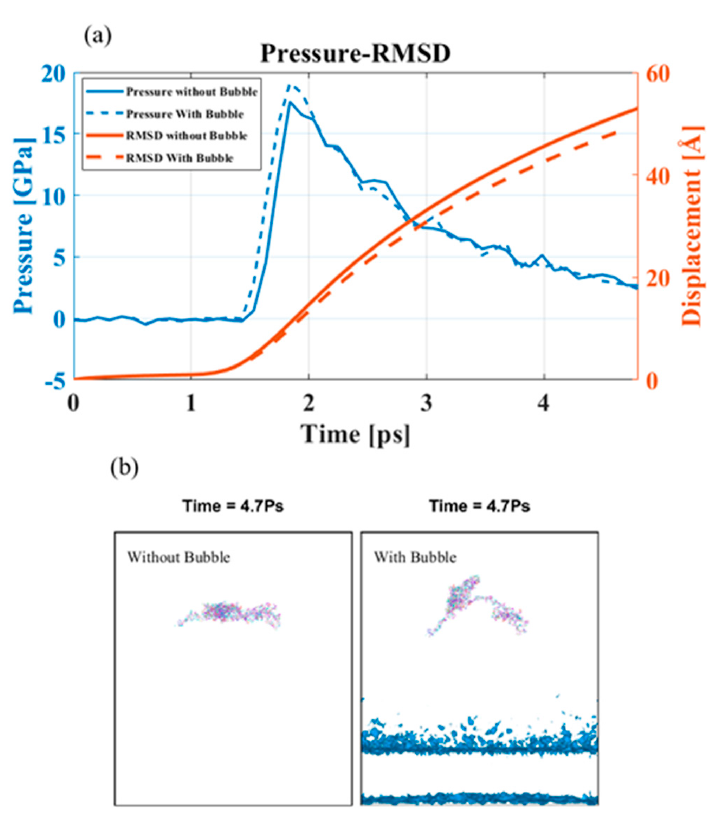
Figure 9. Bubble-induced shock propagation ( a ) Pressure on the bubble-projected area and RMSD value. ( b ) Bubble-projected area of the PNN at 4.7 ps in presence and absence of bubble.